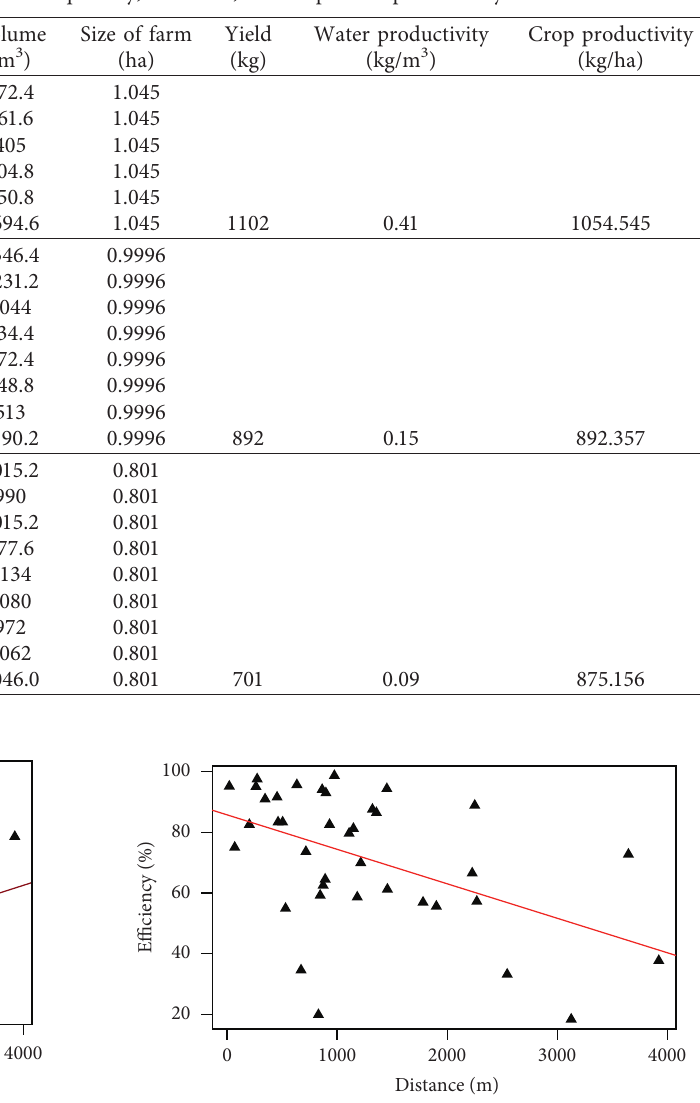
Figure 7: Loss versus distance. Figure 8: Efficiency versus